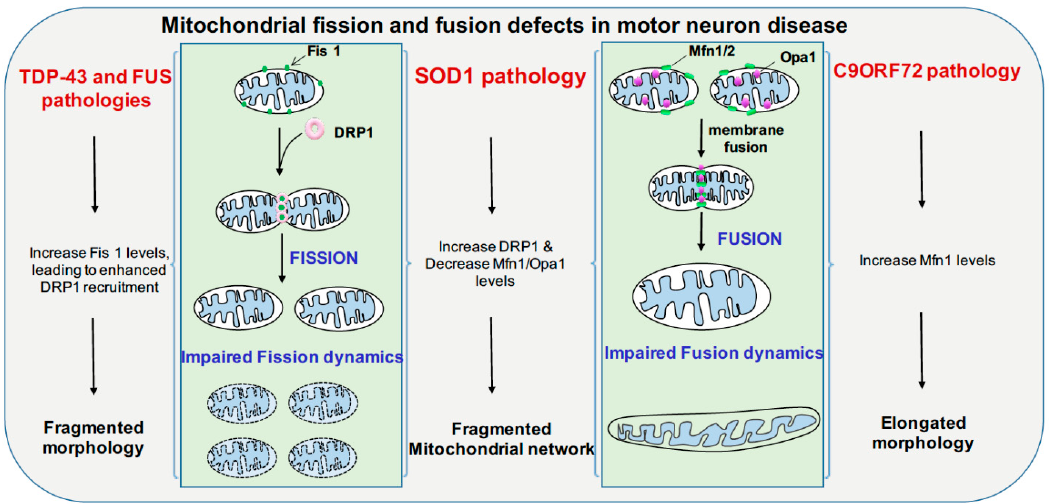
Figure 1. Mitochondrial fission and fusion defects in motor neuron disease and plausible